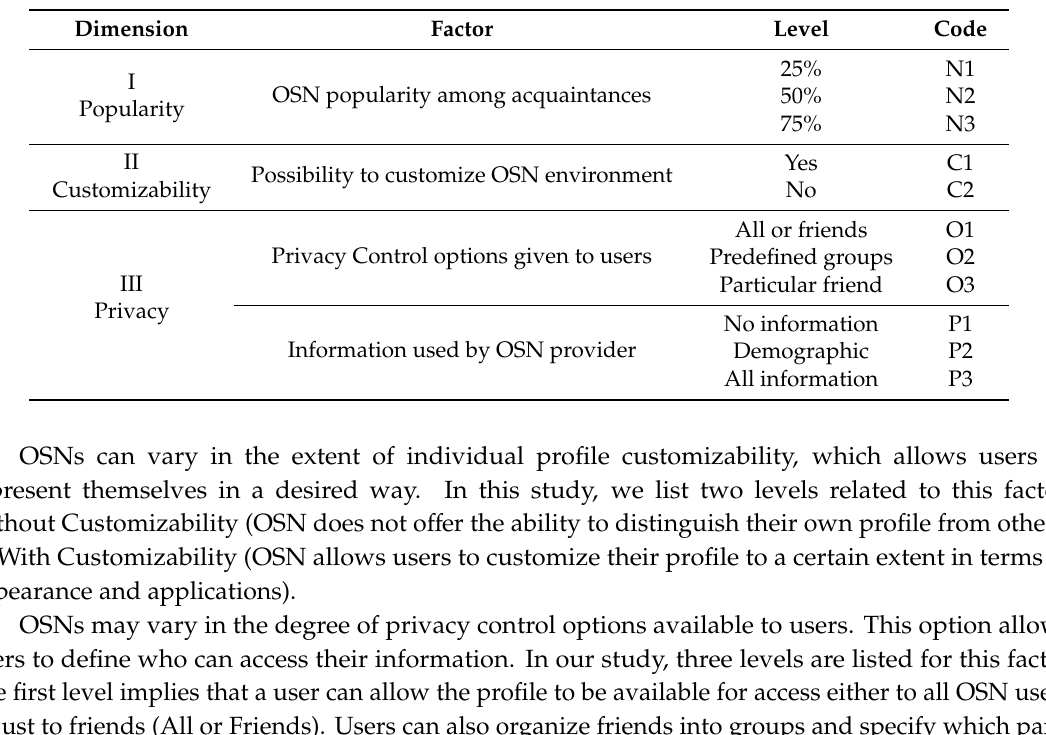
Table 1. Factors and factor levels used in survey. OSN: online social